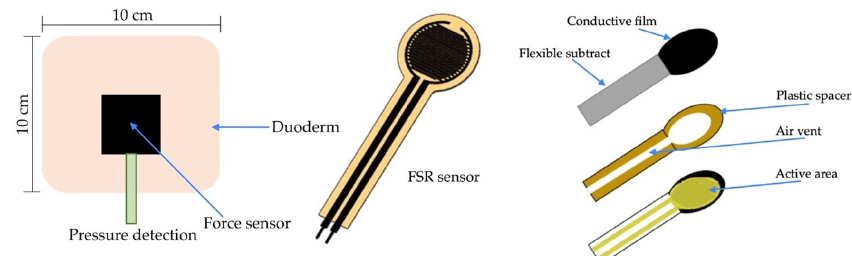
Figure 6. Pad sensor.